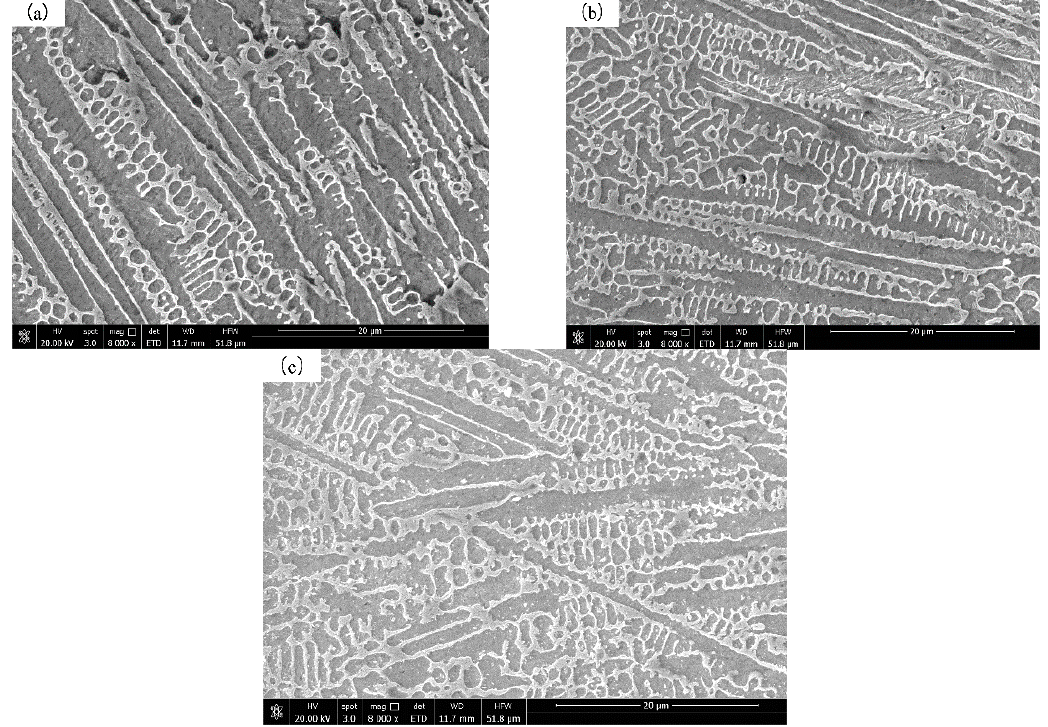
Figure 7. SEM of measuring the secondary dendrite arm spacing at: ( a ) 150 mm/min; ( b ) 200 mm/min; ( c ) 250 mm/min. Table 4. Measurement results of secondary dendrite arm spacing.